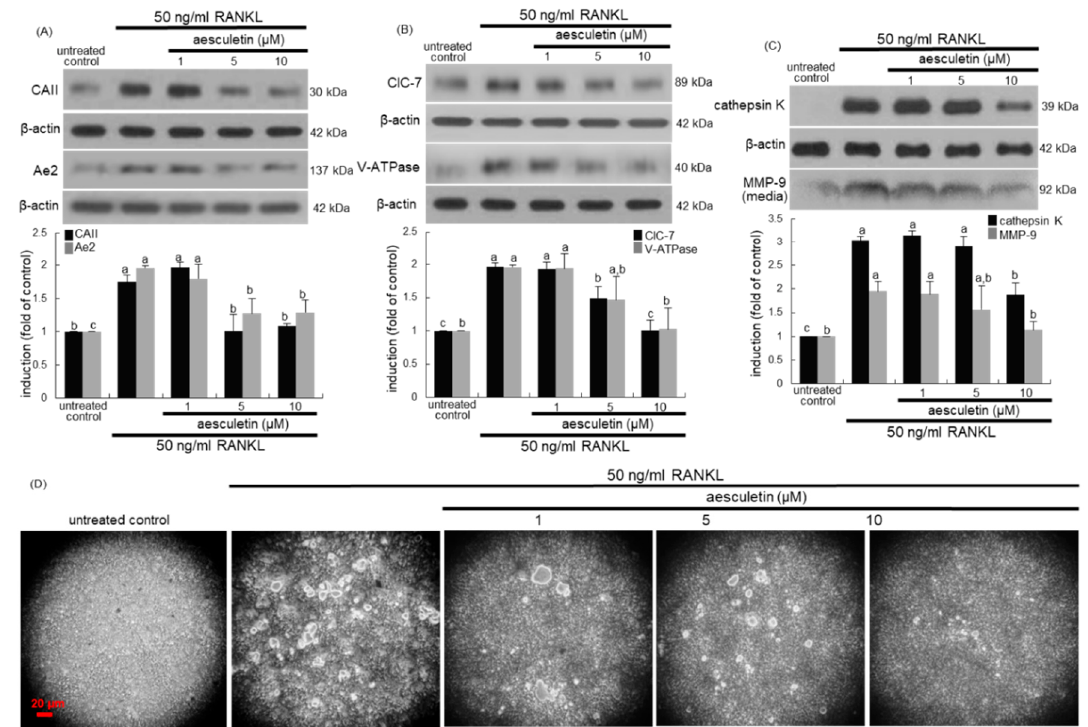
Figure 3. Inhibition of induction of carbonic anhydrase II (CAII), anion exchange protein 2 (Ae2), chloride channel 7 (ClC-7), vacuolar-type H(+)-ATPase (V-ATPase), and cathapsin K ( A , B ), matrix metalloproteinase 9 (MMP-9) secretion ( C ), and bone resorption ( D ) by aesculetin. Raw 264.7 cells were cultured in minimum essential medium alpha medium ( α -MEM) with 50 ng/mL receptor activator of nuclear factor- κ B ligand (RANKL) in the absence or presence of 1–10 μ M aesculetin for 5 days. Whole-cell lysates were subject to SDS-PAGE and Western blot with a specific antibody against CAII, Ae2, ClC-7 V-ATPase, and cathapsin K ( A , B ). An equal volume of culture medium was subject to sodium dodecyl sulphate-polyacrylamide gel electrophoresis (SDS-PAGE) and Western blot with a specific antibody against MMP-9 ( C ). β -Actin was used as internal control. The bar graphs (mean ± SEM, n = 3) represent quantitative results of blots obtained from a densitometer. Respective values in double-bar graphs not sharing a small letter are significantly different at p < 0.05. The osteoclast bone resorption was assayed using a commercially available bone resorption assay kit (( D ), three separate experiments). Attached cells were removed, and resorption pits on the plate were visualized under light microscopy. Scale bar = 20 μ m.